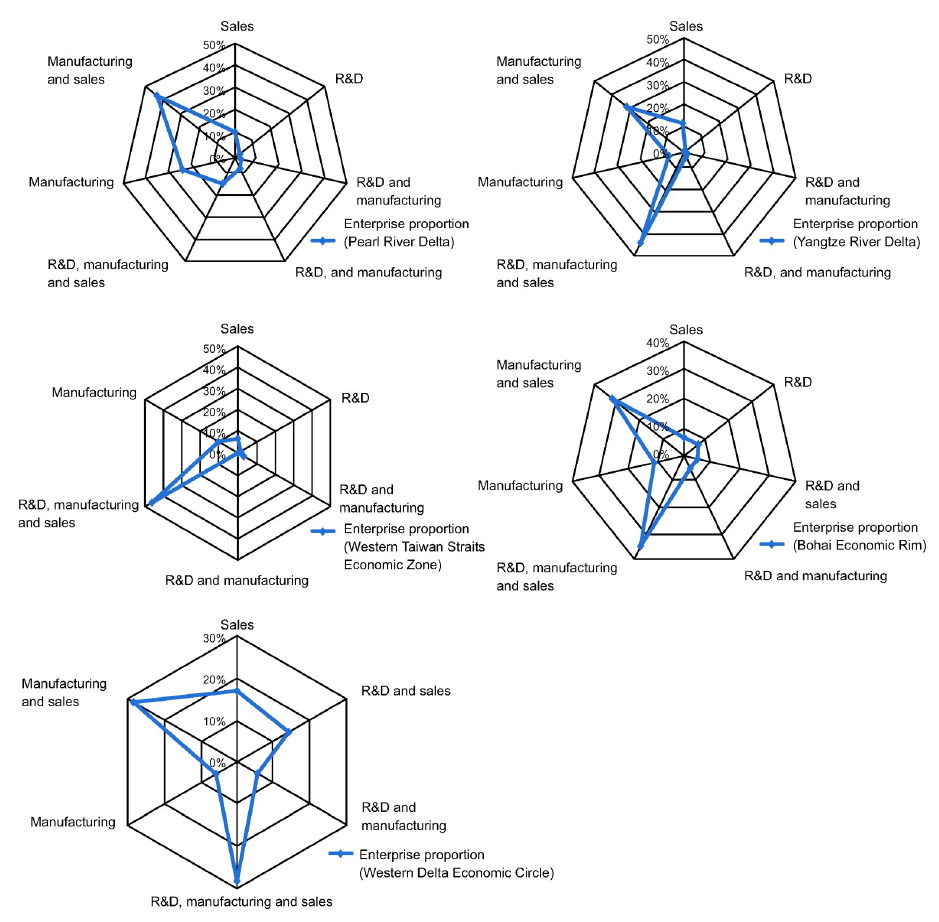
Fig 7. Layout characteristics of value chain models of enterprises in five Taiwanese investment